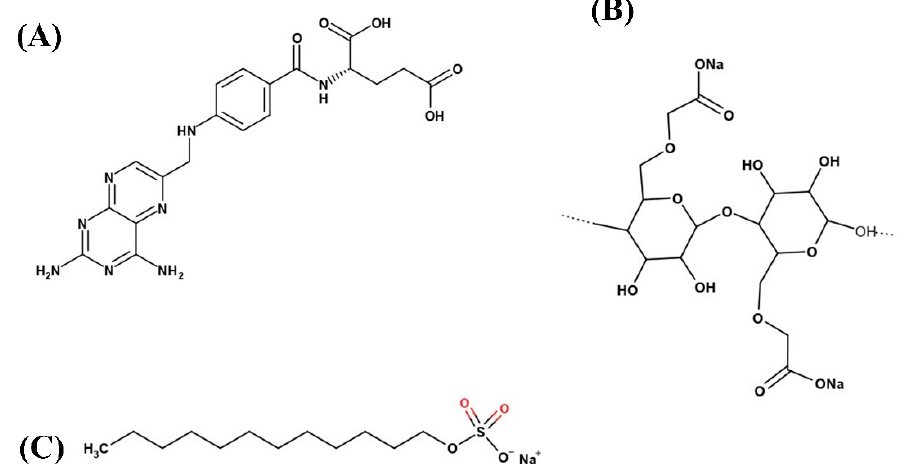
Figure 1. Chemical structure of: ( A ) methotrexate (MTX); ( B ) sodium carboxymethyl cellulose (Na-CMC); and ( C ) sodium lauryl sulfate (SLS).